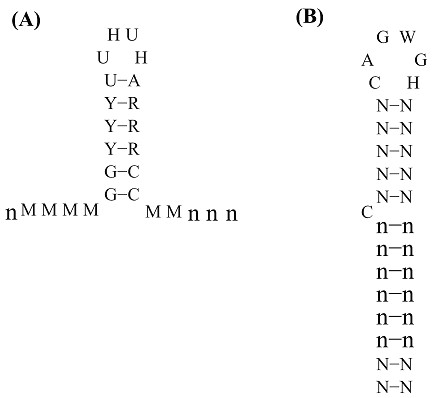
The two pattern-based RNA structures used in this study. (A) Histone 3'-UTR (HSL3) motif. (B) Iron Response Element (IRE) motif. A wildcard, represented by a lowercase letter n, is allowed to appear in a motif. When matching the motif with an RNA secondary structure, the wildcard in the motif can be instantiated into zero or one nucleotide in the secondary structure at no cost. Wildcards are used in places where the length of a region, either single-stranded or double-stranded, is variable. For example, the 5' flanking tail of HSL3 can be 4 or 5 nt long, and the lower part of the stem region of IRE can be 2 to 8 nt long.